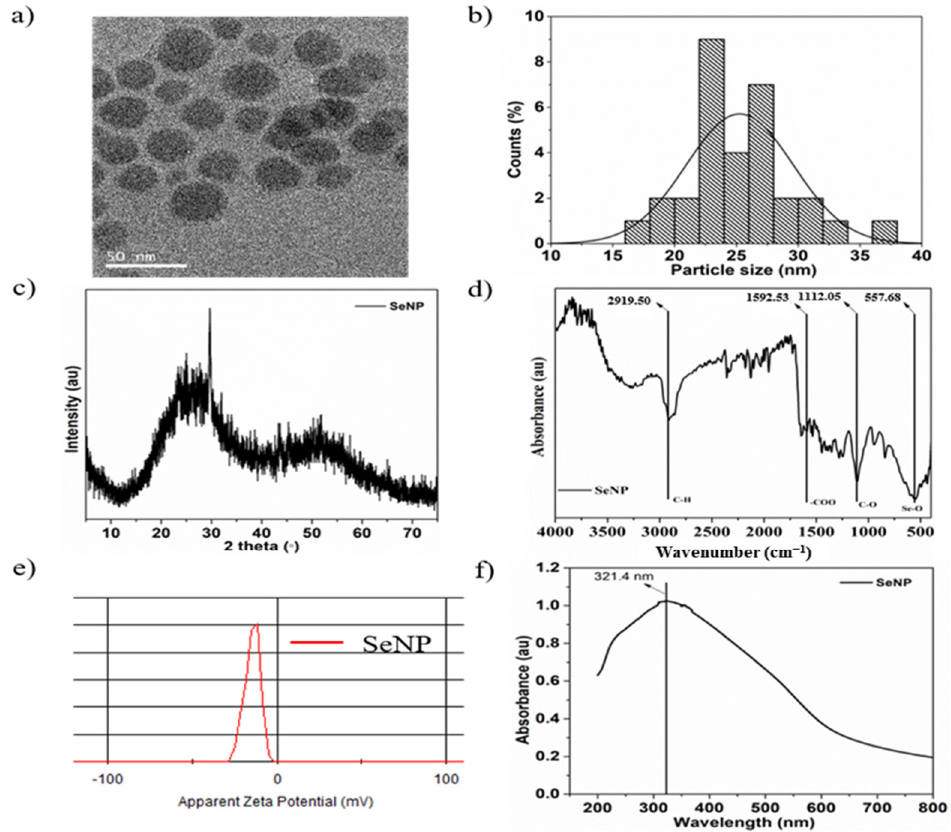
Figure 1. Characterization of selenium nanoparticles (SeNPs): ( a ) Transmission electron microscopy (TEM) image of SeNPs, ( b ) particle size distribution, ( c ) X-ray diffraction (XRD) pattern, ( d ) Fourier transform infrared (FTIR) spectrum, ( e ) ξ -potential, and ( f ) UV-visible spectrum of SeNPs in distilled water.